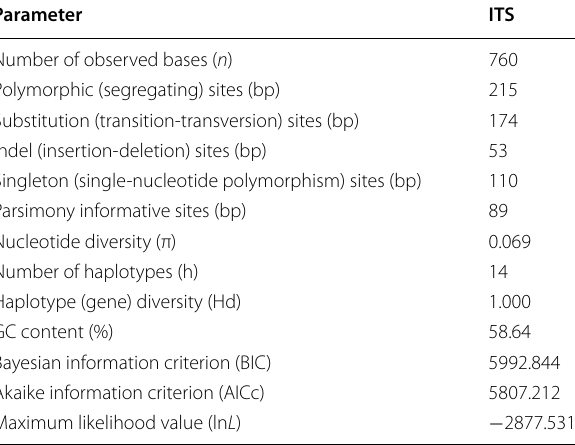
Table 3 The genetic information of ITS sequence of endemic breadfruit ( Artocarpus spp.) from South Borneo, Indonesia a